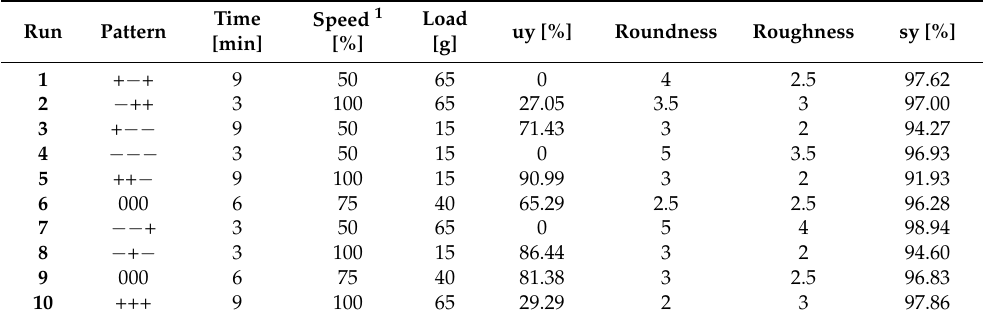
Table 2. Design of Experiment of the spheronisation process and the resulted responses (for all runs